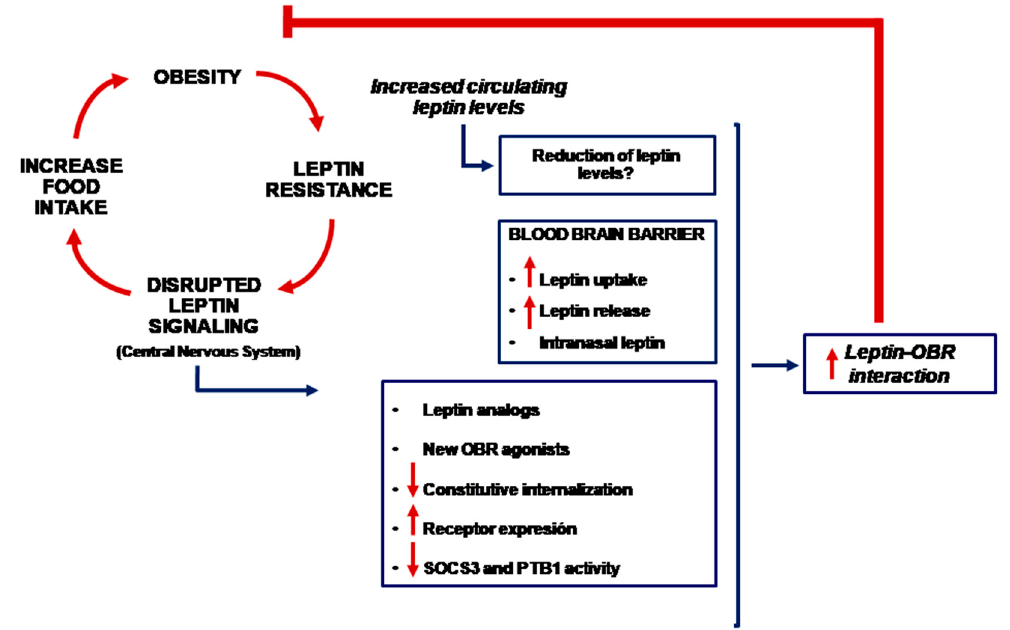
Figure 2. Schematic representation of different anti-obesity therapies based on the use of leptin (OBR = leptin receptor).